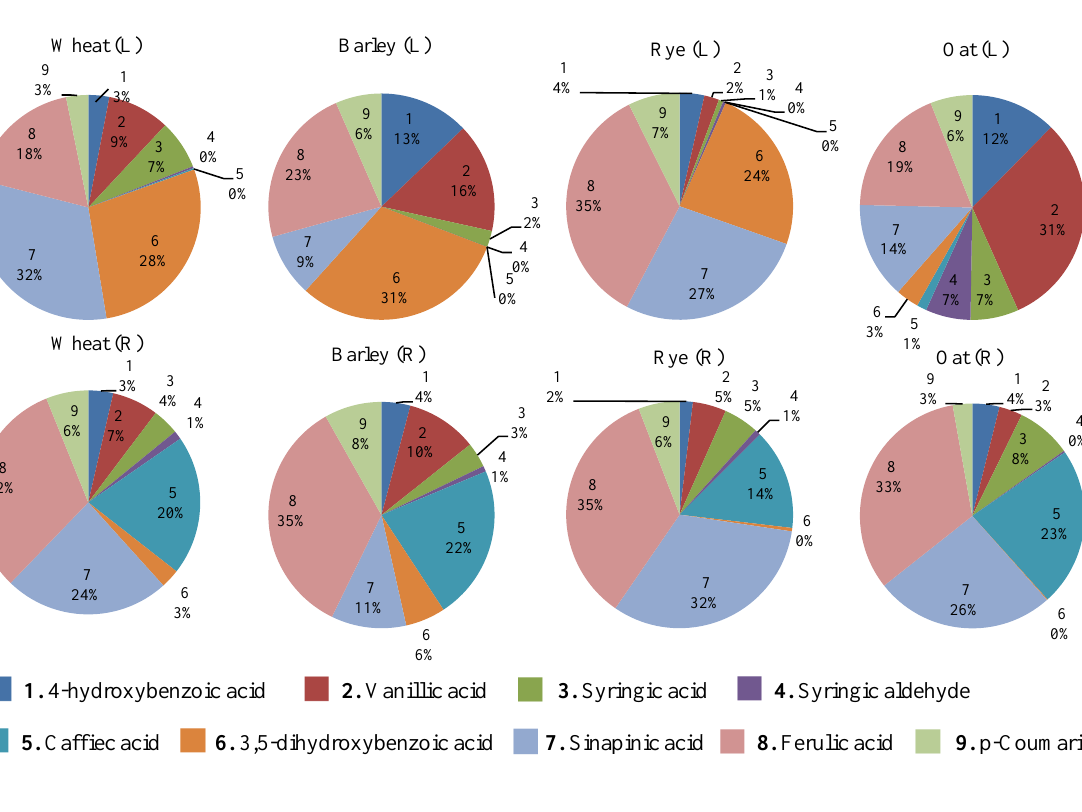
Figure 4. Comparison of relative percentages of the nine most abundant phenolic acids of cereals reported in the literature (L) with the results of the current study (R). In literature the following genotypes were studied: winter wheat ( Triticum aestivum var. aestivum )